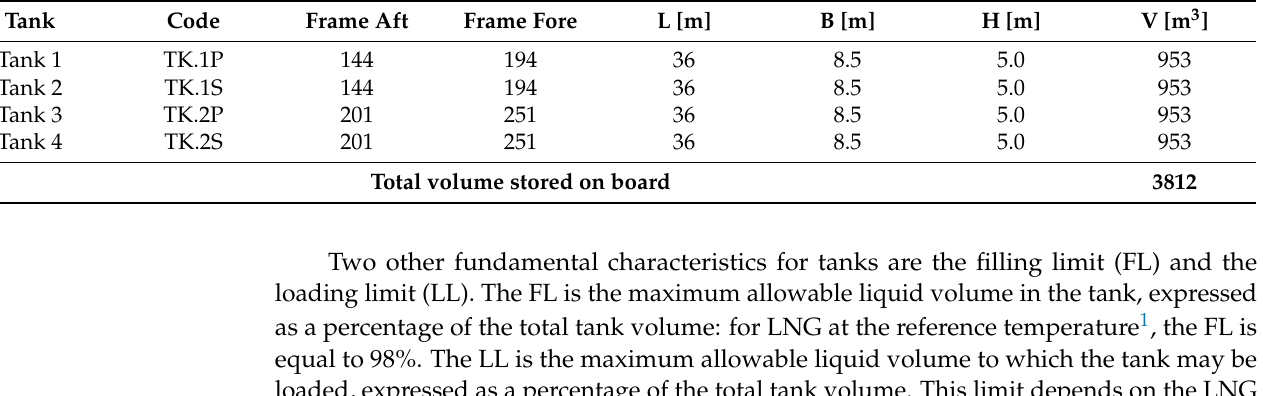
Table 5. Geometric properties and positions of the Type-C bilobed tanks selected.